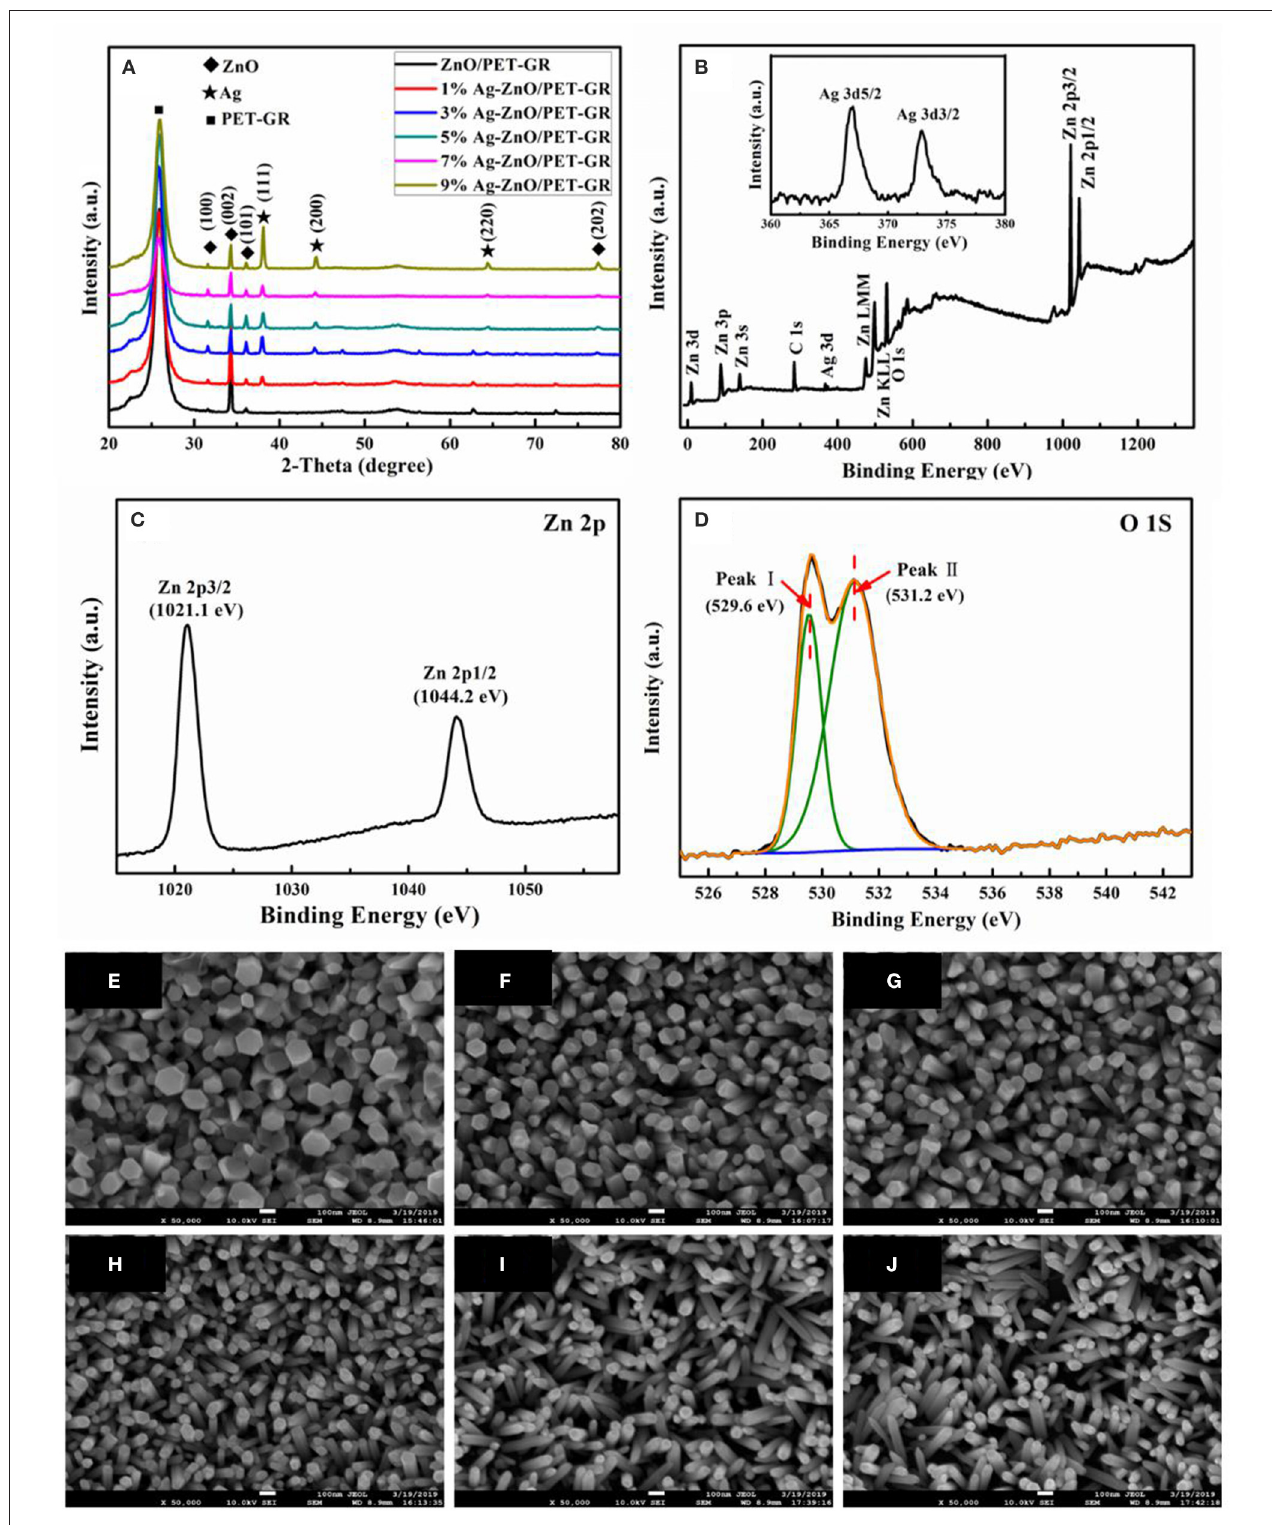
FIGURE 1 | (A) XRD patterns of Ag-ZnO/PET-GR composite structures with different silver nitrate concentrations. The inset in (A) corresponds to the Ag 3d peak; (B) XPS spectra of the Ag-ZnO thin film with a concentration of 0.01M; (C,D) high-resolution spectra at the Zn 2p and O 1s state energies, respectively; (E–J) FE-SEM images of Ag-doped ZnO nanostructures grown on PET-GR substrate at different silver nitrate doping concentrations: (E) 0%, (F) 1%, (G) 3%, (H) 5, (I) 7%, and (J) 9%.